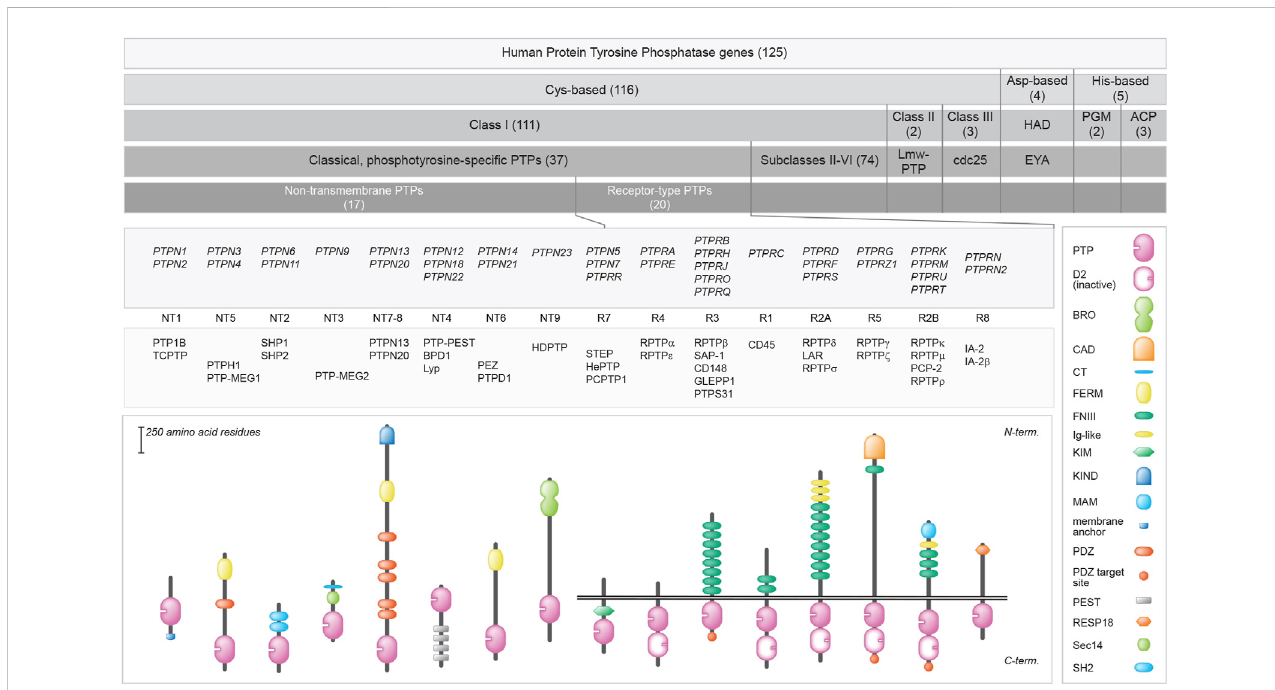
FIGURE 1 Classi fi cation of protein tyrosine phosphatase genes, and protein domain structure for the 37 classical PTPs. Upper 5 bars summarize the build-up of (sub) classes within the family. The number of genes within the (sub) classes are indicated in between brackets. Below, the gene (italics), subtype codes, and protein names of the classical PTPs, as well as their schematic structures, are given. The horizontal twin black lines represent the cell membrane. Protein domainrepresentationsareexplainedontheright.BRO,yeastBro1homologousdomain;CAD,carbonic anhydrasedomain;CT,CRAL-TRION-terminal homology domain; D2, inactive PTP domain; FERM, 4.1 protein-ezrin-radixin-moesin; FNIII, Fibronectin typethree; Ig-like, Immunoglobulin-like; KIM, kinase interaction motif; KIND, kinase non-catalytic N-lobe; MAM, meprin, A-5 neuropilin, and RPTP μ ; PDZ, postsynaptic density-95/discs large/ZO1 homology; PEST, proline-glutamic acid-serine-threonine-rich area; Pro-rich, proline-rich area; PTP, catalytic domain; RESP18, regulated endocrine-speci fi c protein-18 homology domain; Sec14, Sec14 homology; SH2, Src Homology 2. Classi fi cation is according to Alonso and Pulido (Alonso et al., 2016; Alonso and Pulido, 2016). Subtype codes come from Andersen et al. (Andersen et al.,